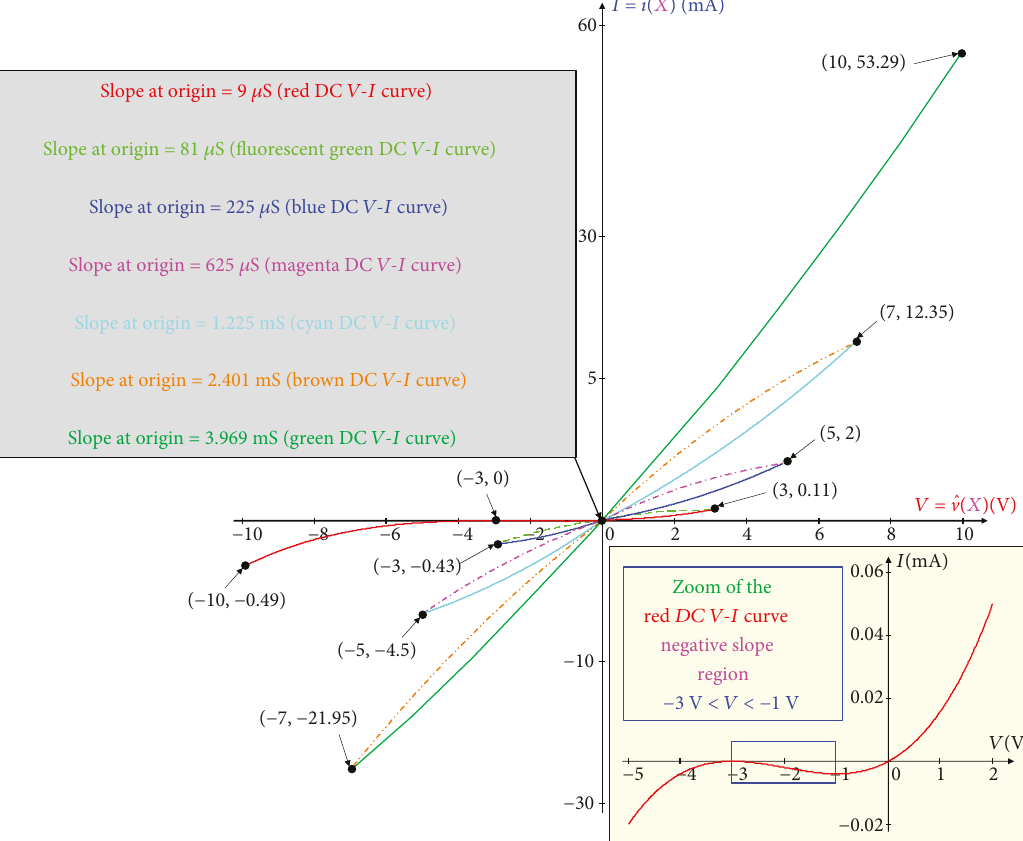
Figure 5: DC V - I plot of the 6-lobe corsage memristor over input voltage − 10V ≤ V ≤ 10 V. The left inset shows the conductance values at V =0 V. The right inset shows the zoomed portion of the red DC V - I curve over the voltage range − 5 V ≤ V ≤ 2V